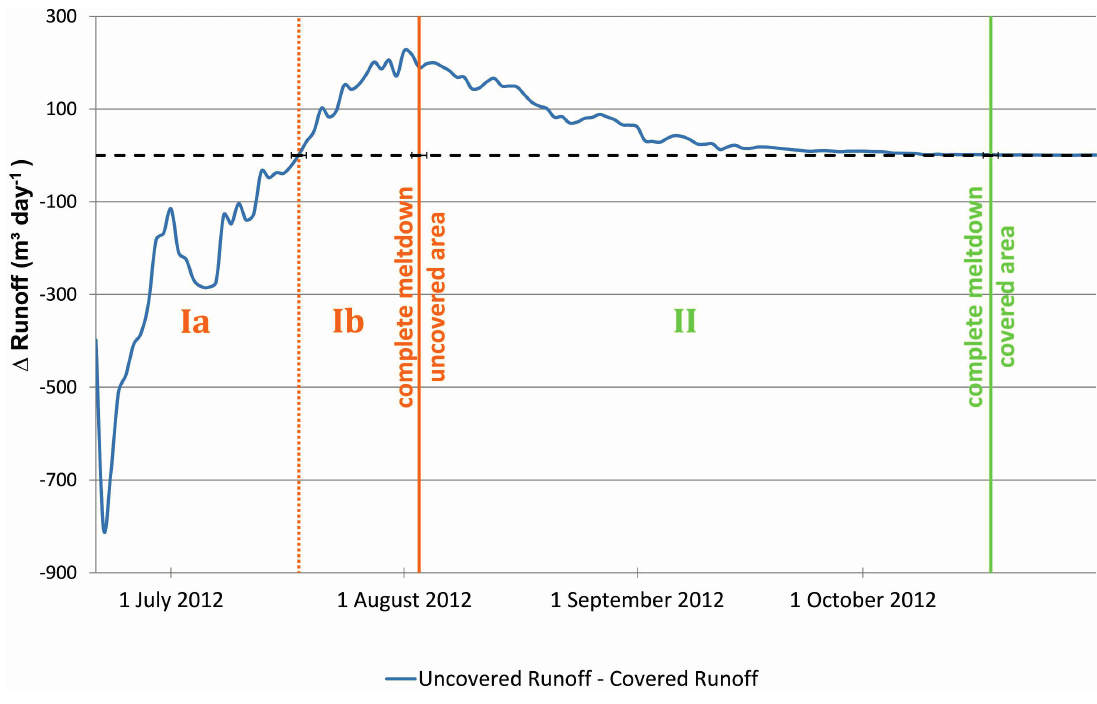
Figure 12. Difference between runoff from a covered and an uncovered snow field on 3200 m a.s.l. simulated with the distributed temperature-index